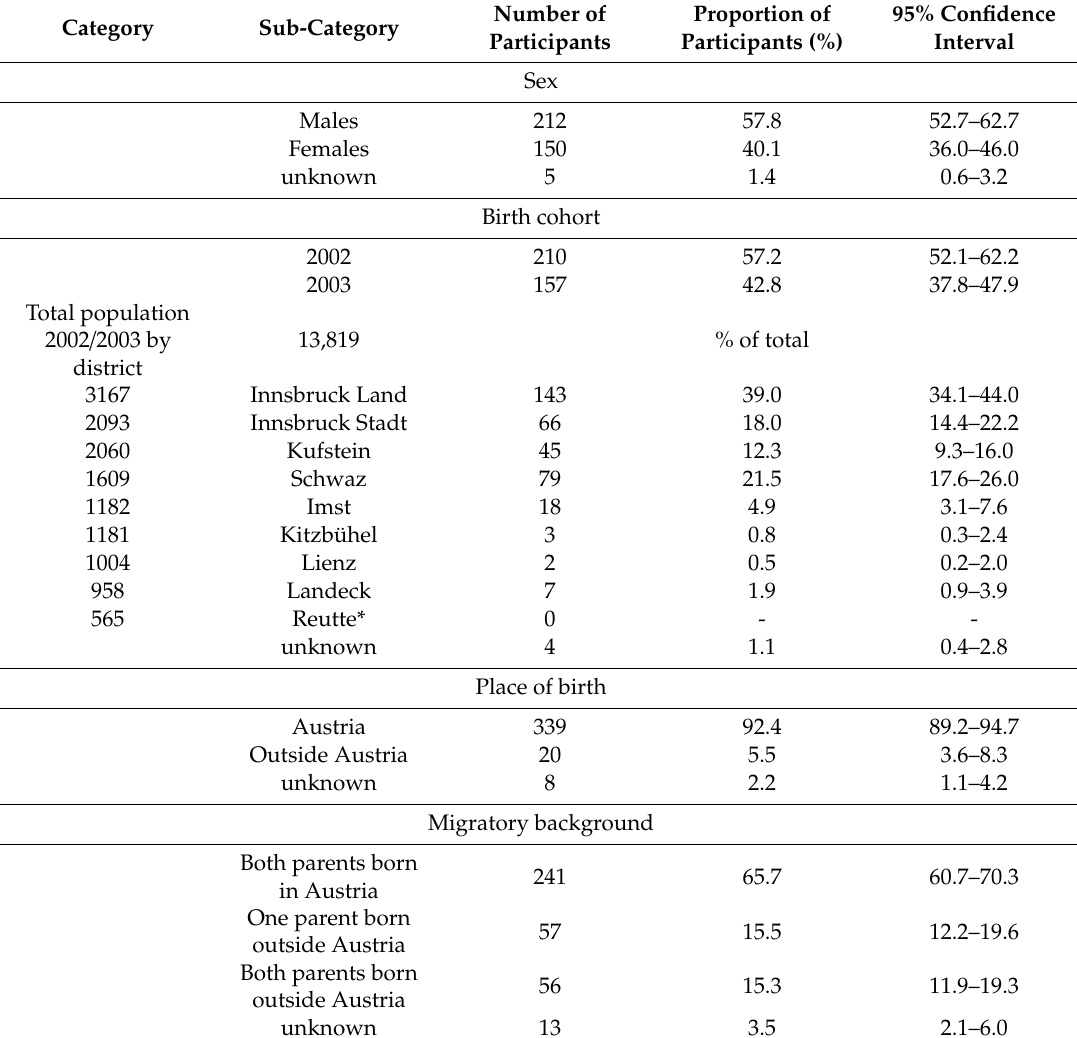
Table 1. Demographic characteristics of survey participants ( n =